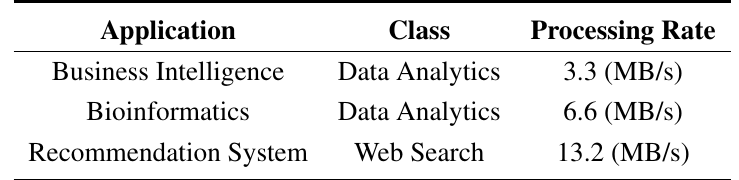
Table 7. Cloud Applications